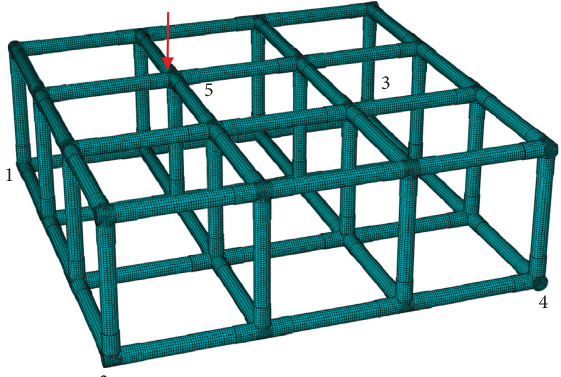
Figure 1: Finite element model and layout of measure points of